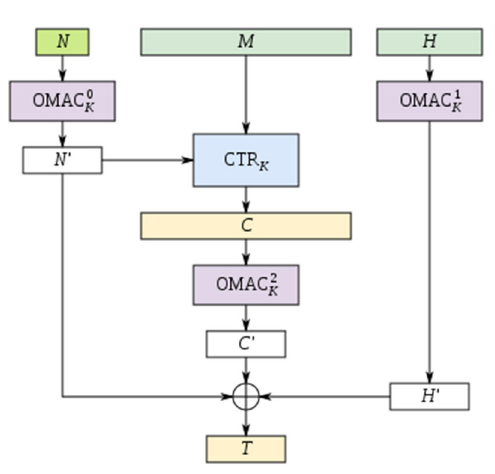
Figure 12. The general architecture of EAX (M—message, K—key, H—authenticated header, N— nonce, C—encrypted message, T—authentication